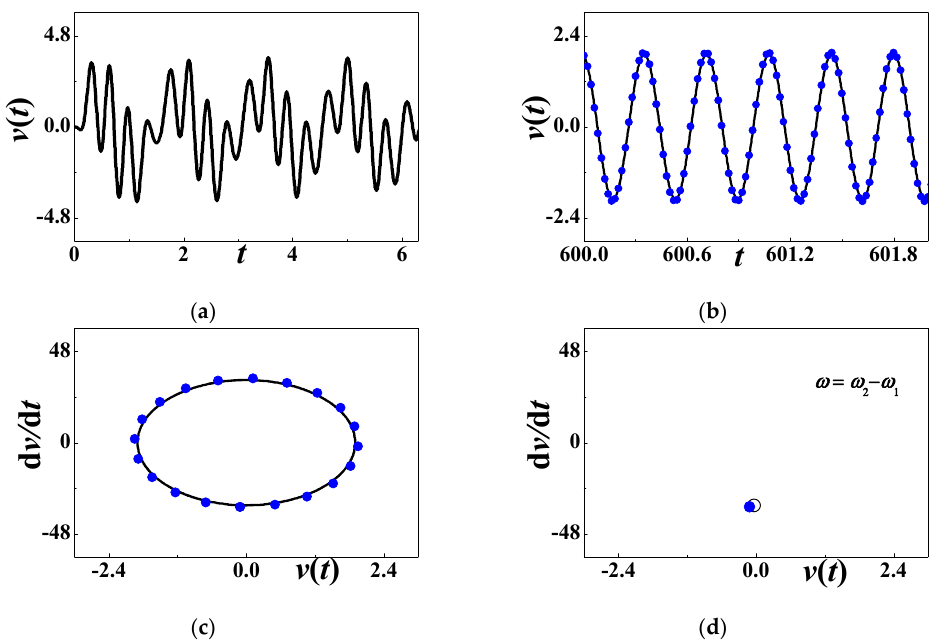
Figure 5. The small-amplitude periodic response when ω = ω 2 − ω 1 : ( a ) initial history; ( b ) steady-state response; ( c ) phase diagram; ( d ) Poincare map. The solid blue dots stand for analytical prediction and others for numerical simulation.